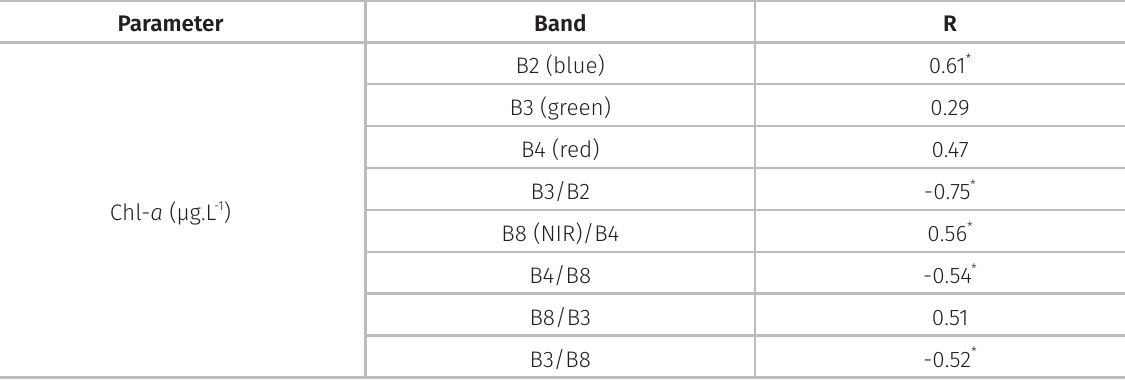
Table III. Pearson’s correlation coefficient (R) between the Chl- a data analyzed in the Mirim lagoon and the reflectance of the spectral